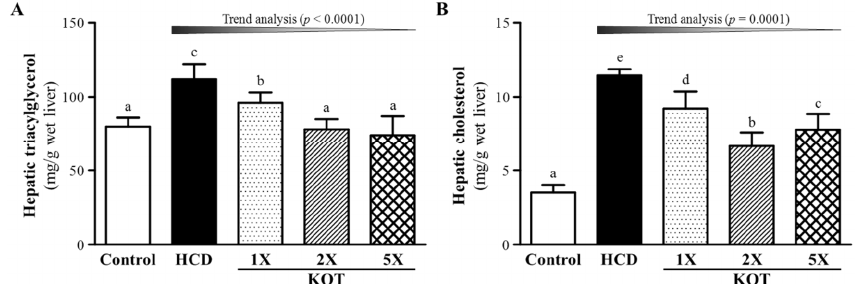
Figure 4. Effect of a six ‐ week supplementation with KOT on hepatic triglycerides (TG) ( A ) and total cholesterol (TC) ( B ) levels in hyperlipidemic hamsters. Data are the mean ± SD, n = 8 hamsters in each group. Columns with different letters (a, b, c, and d) significantly differ at p < 0.05 by a one ‐ way ANOVA. HCD (high ‐ cholesterol diet), HCD and the same volume of solution equivalent to BW; KOT ‐ 1X, HCD and 2787 mg/kg/day KOT; KOT ‐ 2X, HCD and 5573 mg/kg/day KOT; KOT ‐ 5X, HCD and 13,934 mg/kg/day KOT. KOT: tomato juice from Kagome Ltd.